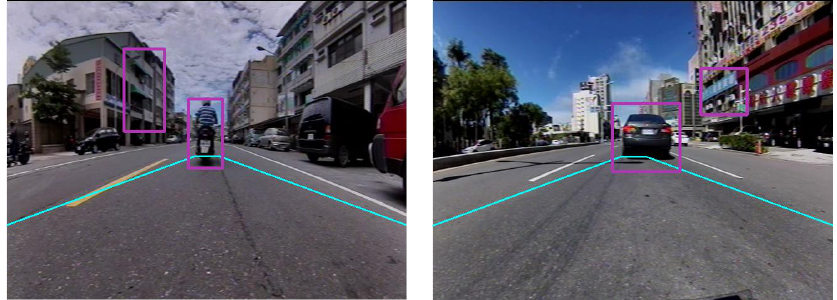
Figure 17. Error detection of the Haar-like algorithm.